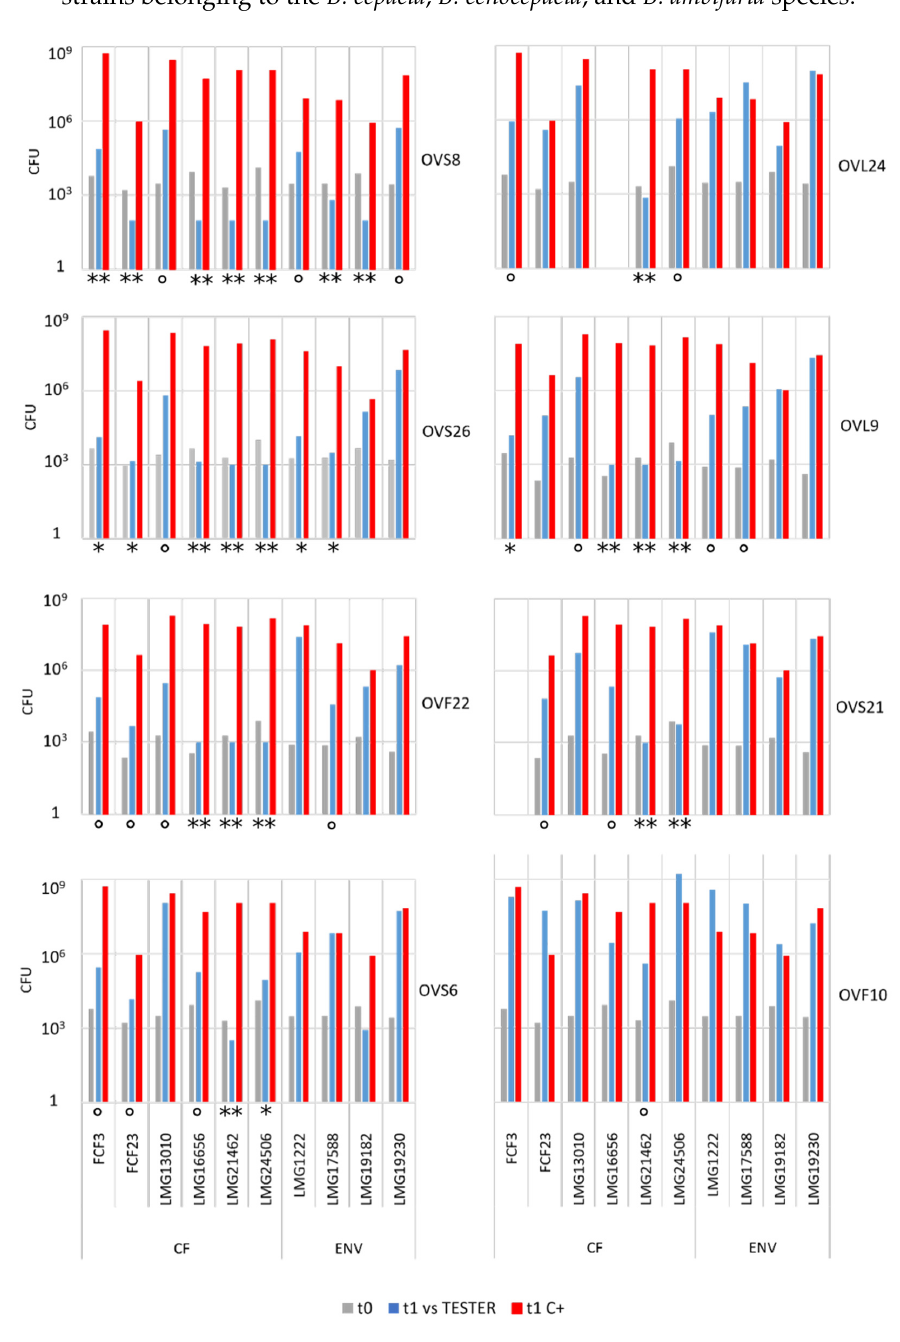
Figure 2. Schematic representation of the number of colony-forming units (CFU) of each target strain calculated at the beginning (t 0 , grey bar) and at the end (t 1 ) of the cross-streaking experiments in the absence (red bar) or in the presence (blue bar) of the endophytic tester strains. The antibacterial activity exerted by the endophytic VOCs was classified as follows: (**) bactericidal, if the viable titer of target strain in the presence of the tester was lower than 0.015%; (*) bacteriostatic, when the viable titer was between 0.015% and 0.05%; (°) able to reduce the growth of the target, for values between 0.05% and 2%. The experiments were repeated twice.